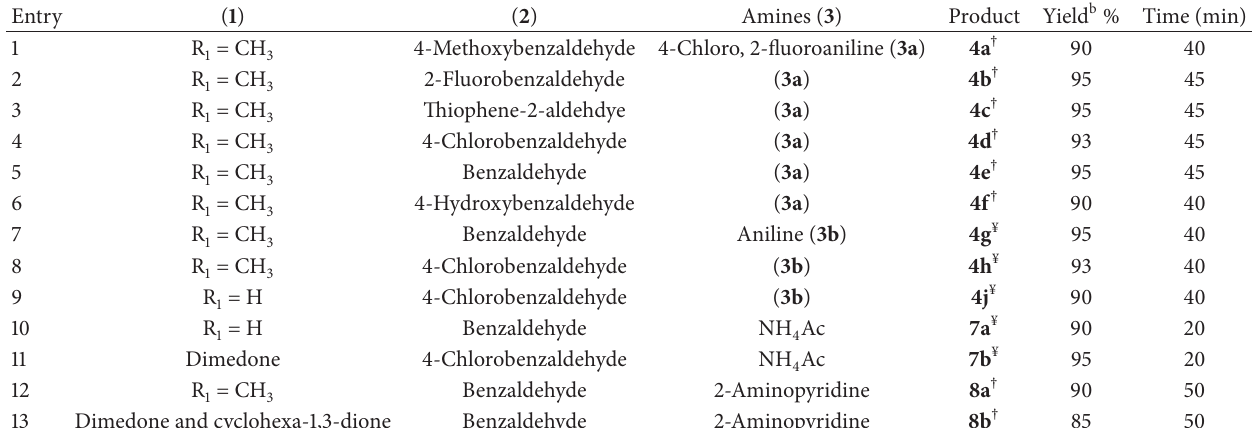
Table 2: A small library of acridines synthesized under sonic condition a .